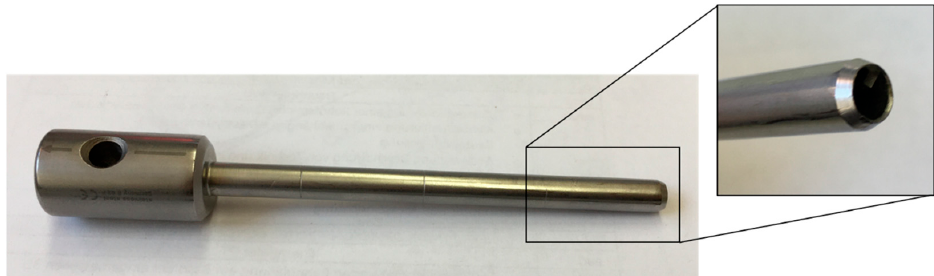
Figure 1. Shepard cylinder osteotome (chisel) used for harvesting of trabecular bone cylinders.